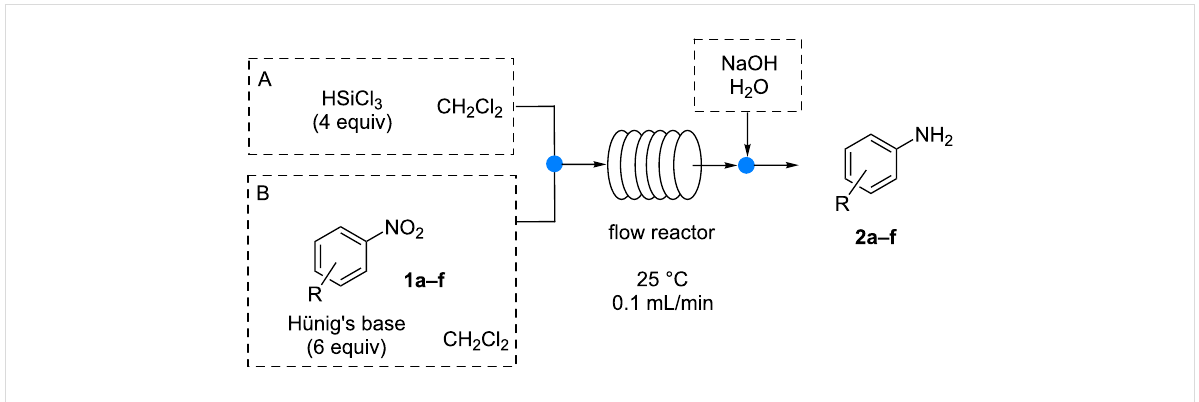
Scheme 2: Continuous flow reduction of aromatic nitro compounds.